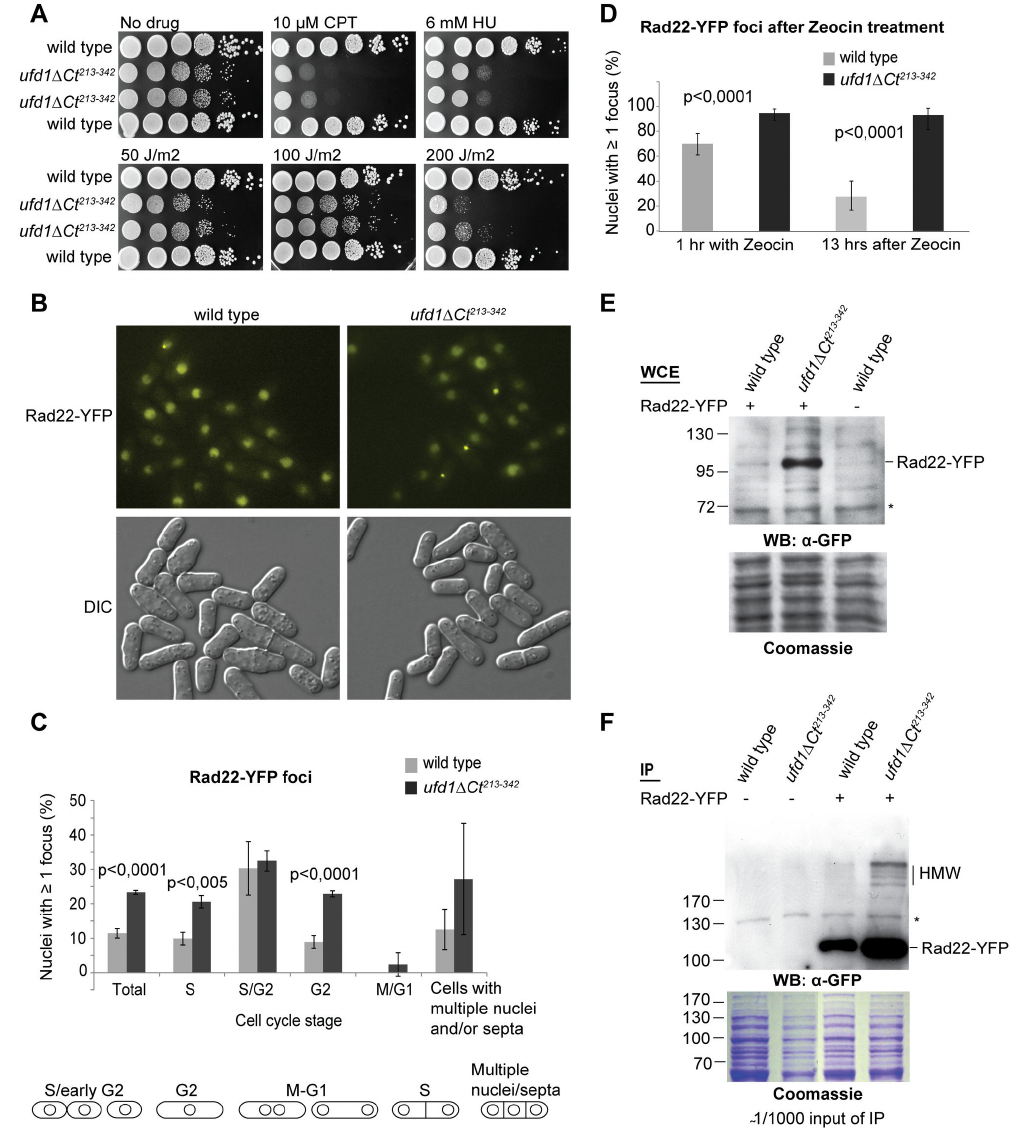
Figure 4. Ufd1 is required for the maintenance of genome integrity. (A) ufd1ΔCt 213-342 cells are sensitive to DNA damage: 10- fold dilution series of the indicated strains were spotted onto YES plates containing camptothecin (CPT) or hydroxyurea (HU), or subsequently exposed to UV irradiation as indicated. (B) Fluorescence imaging of wild-type and ufd1ΔCt 213-342 asynchronous cultures expressing Rad22-YFP. (C) ufd1ΔCt 213-342 cells display an increased frequency of spontaneous Rad22 foci: Nuclei were classified according to their position in the cell cycle based on cell morphology. Bars represent the percentage of nuclei with at least one Rad22-YFP focus averaged from three independent experiments. Error bars correspond to the standard deviations for the combined data and p-values were calculated with a Fishers exact test. More than 300 cells of each strain were counted in each experiment, the numbers are reported in Table S2. Only very few cells were counted in the ‘multiple nuclei/septa’ category, giving rise to the large standard deviations in this category. (D) ufd1ΔCt 213-342 cells are unable to recover from Zeocin-induced damage: Rad22-YFP foci were quantified after 1 hr of growth in Zeocin-containing medium (300 µg/ml) and again 13 hr after Zeocin had been removed from the media. Between 50 and 100 cells were counted for each strain at each time point; error bars indicate exact binomial 95% confidence intervals. Indicated p-values were obtained with a Fishers exact test. Fluorescence images are shown in Figure S3. (E) and (F) Rad22-YFP accumulation in ufd1ΔCt 213-342 cells: (E) Rad22-YFP from whole cell extracts of the indicated strains was detected by an anti-GFP antibody. (F) Rad22-YFP was affinity-purified from a wild-type or ufd1ΔCt 213-342 genetic background and detected by anti-GFP immunoblotting. HMW indicates higher molecular weight species of Rad22-YFP accumulating in ufd1ΔCt 213-342 . * indicates a crossreacting species. doi: 10.1371/journal.pone.0080442.g004 PLOS ONE |